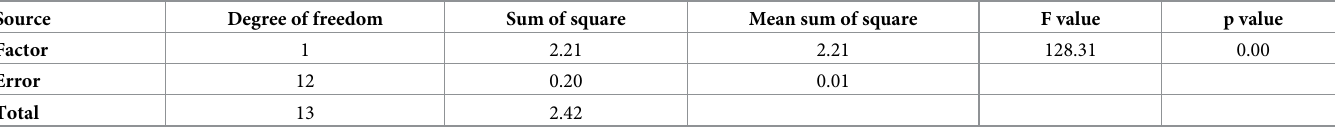
Table 9. ANOVA results for quality